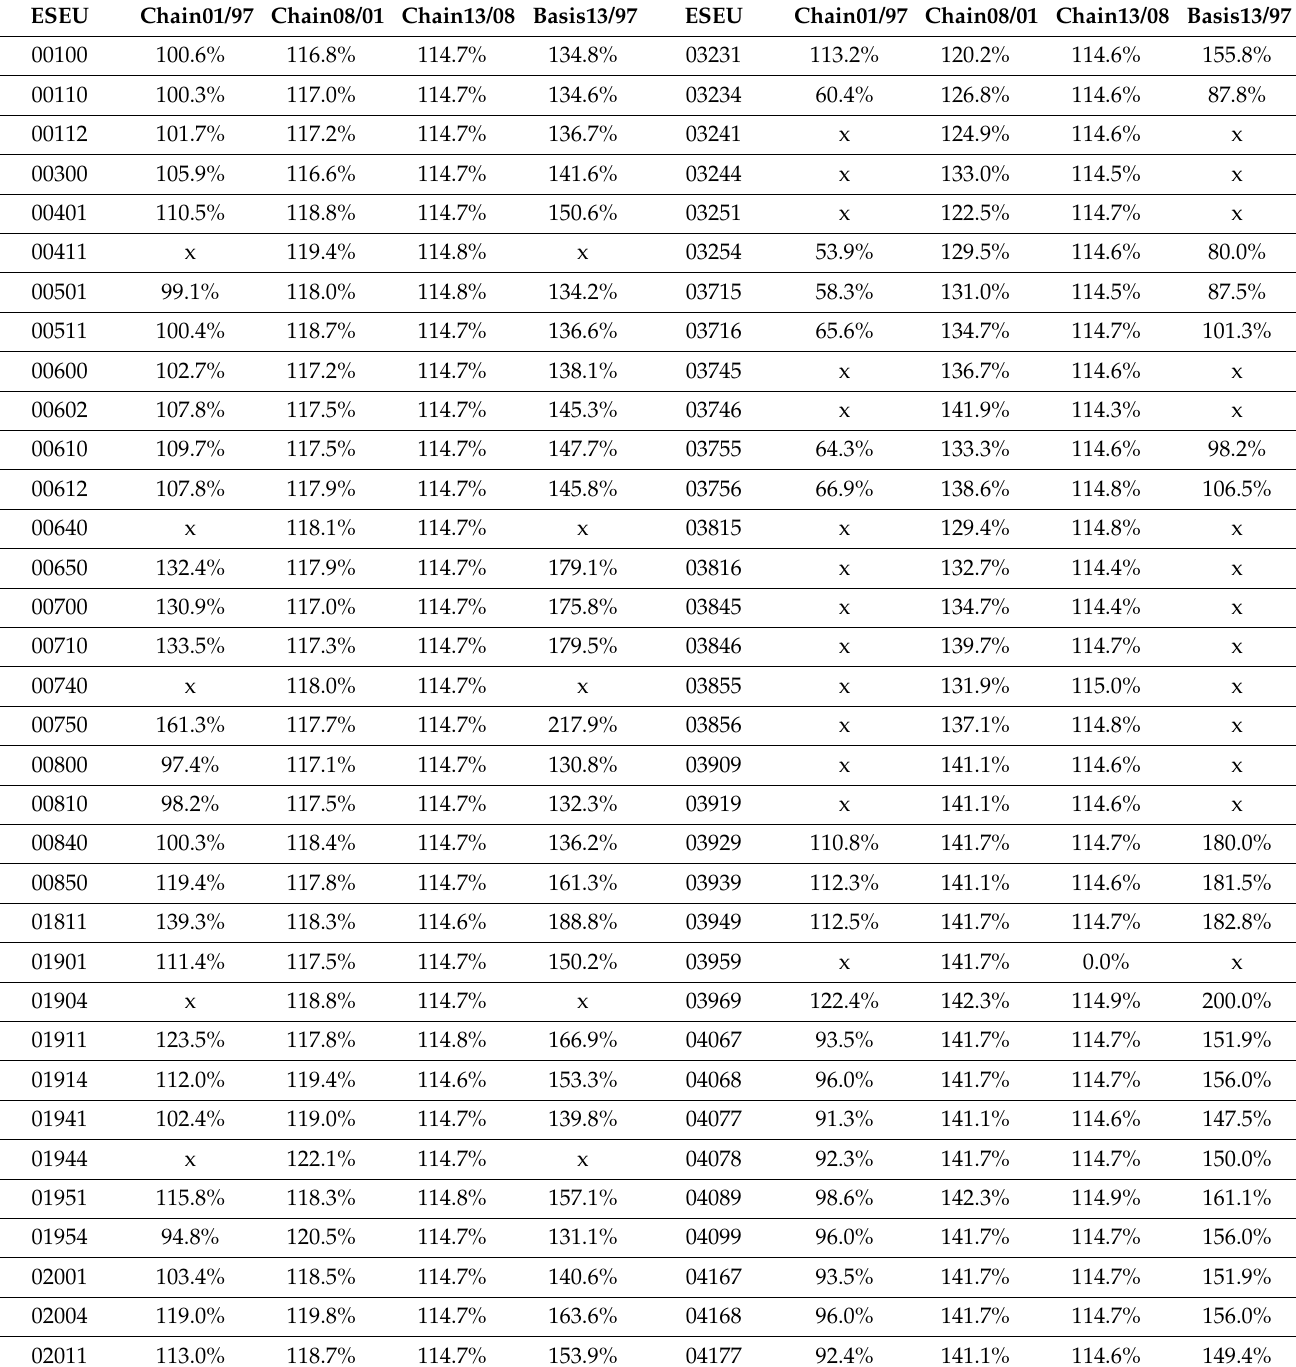
Table 3. Chain and basis index for ESEUs (1997, 2002, 2008, 2013, climate region